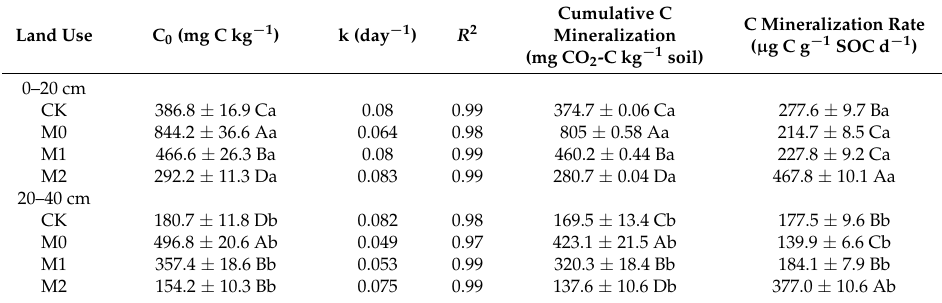
Table 3. Parameter values for the first-order kinetic model C = C 0 (1 − e − kt ) of carbon mineralization as well as decomposition rate (mean ± SD, n = 3).